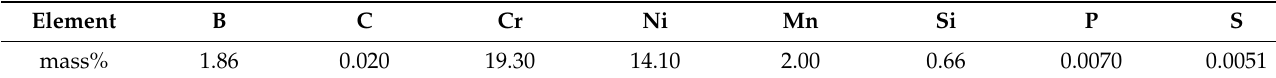
Figure 2. Metallographic of borated stainless steel (BSS) powder. Table 1. Powder chemical composition in mass%.